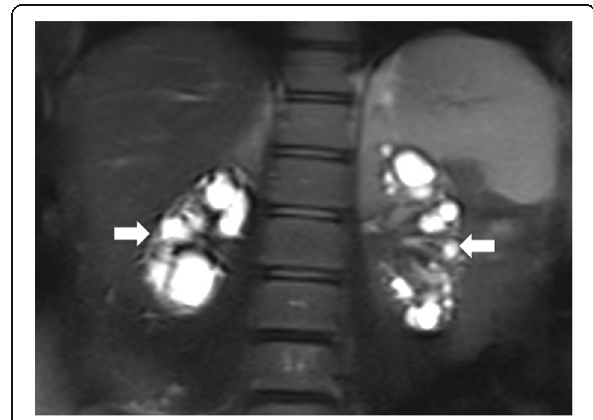
Fig. 20 A 13-year-old female patient with known histopathologically proven nephronophthisis now presenting with flank pain. The patient is on chronic hemodialysis. Coronal plane T2W MR image shows multiple cysts in both kidneys located at the corticomedullary junction. There was no discernible healthy renal parenchyma in the kidneys. Also note that both kidneys (arrows) are small in their overall sizes in contrast to ARPKD